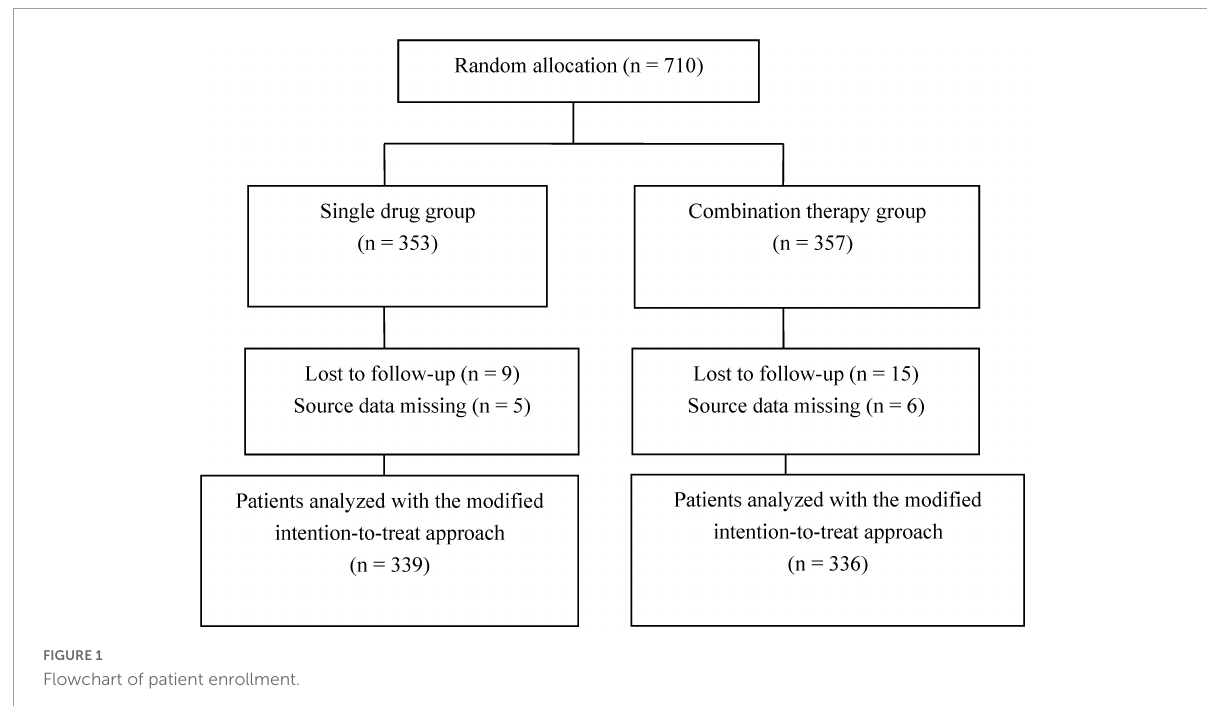
FIGURE1 Flowchart of patient enrollment.